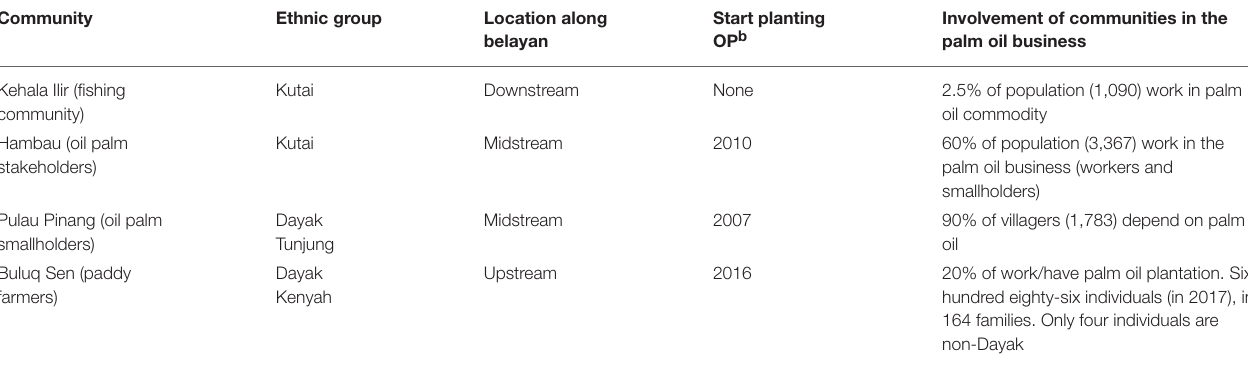
TABLE 1 | Typology of communities along Belayan River, Kutai Kartanegara.